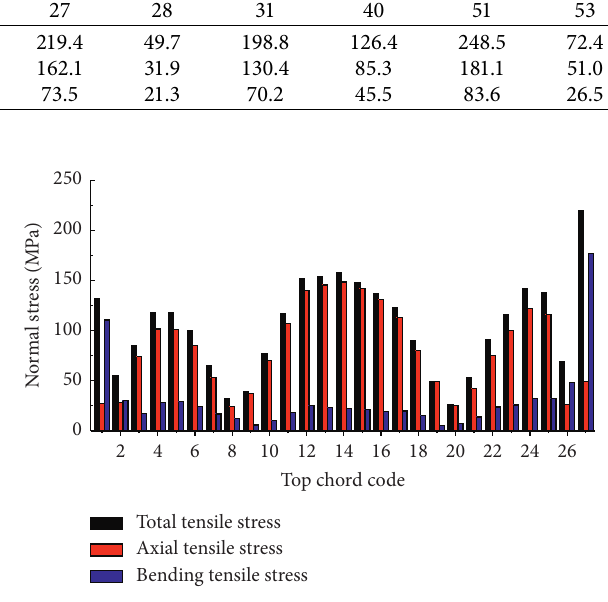
Figure 13: Comparison curve of stress component of discrete